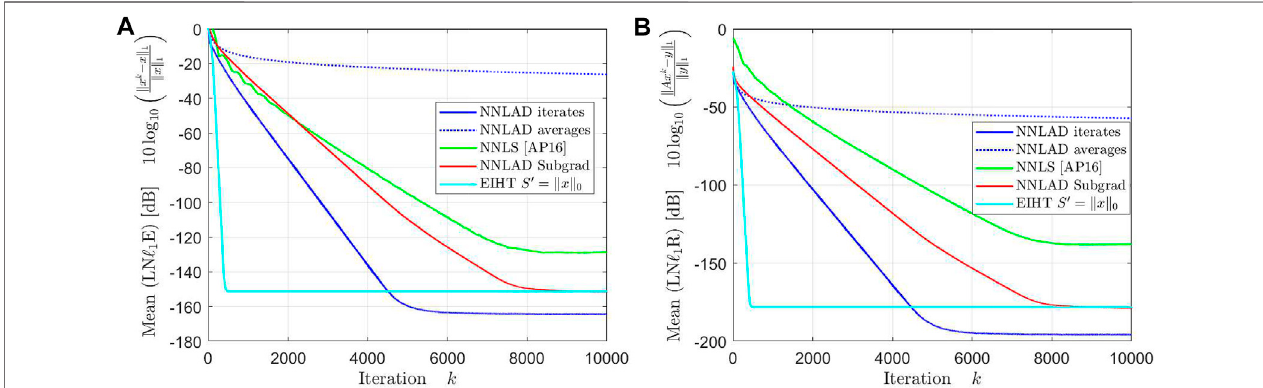
FIGURE 8 | Convergence rates of certain iterated methods with respect to the number of iterations. A is Bernoulli for NNLS and D-LRBG for the others.